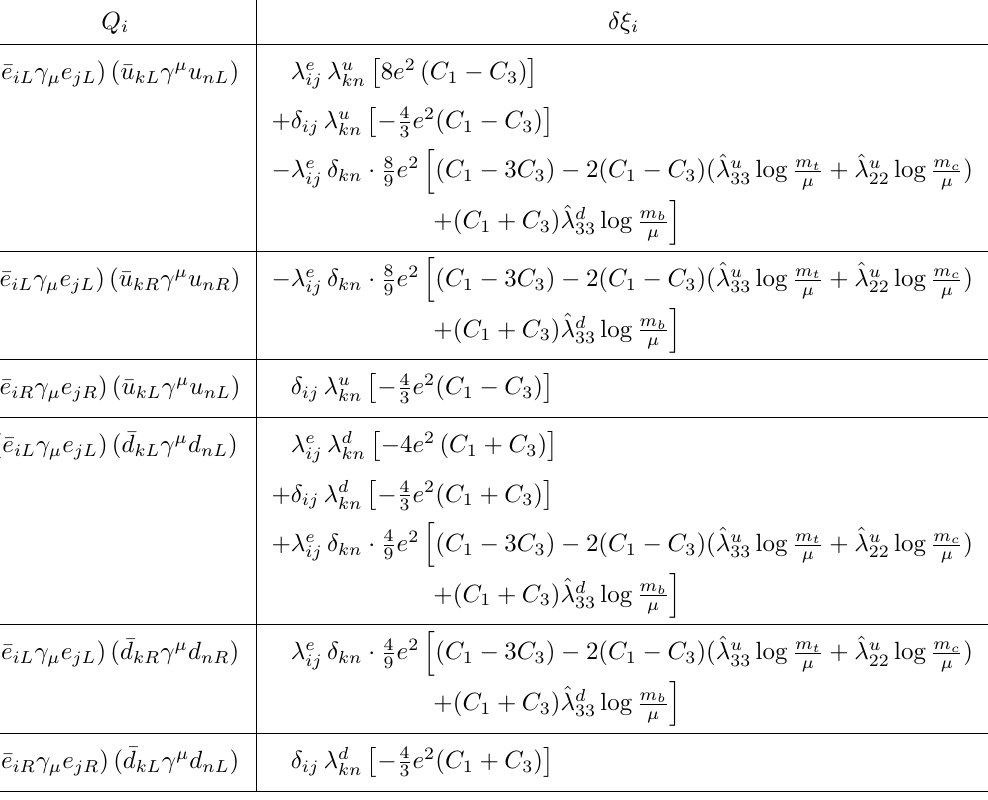
Table 8 . Operators Q i and coe(cid:14)cients (cid:14)(cid:24) i for the semileptonic part of the e(cid:11)ective Lagrangian (cid:14) L QED involving charged leptons and neutral currents. For the down-type quarks generation indices e(cid:11) run from 1 to 2, while for up-type quarks we only keep the (cid:12)rst generation. We set ^ (cid:21) u;d